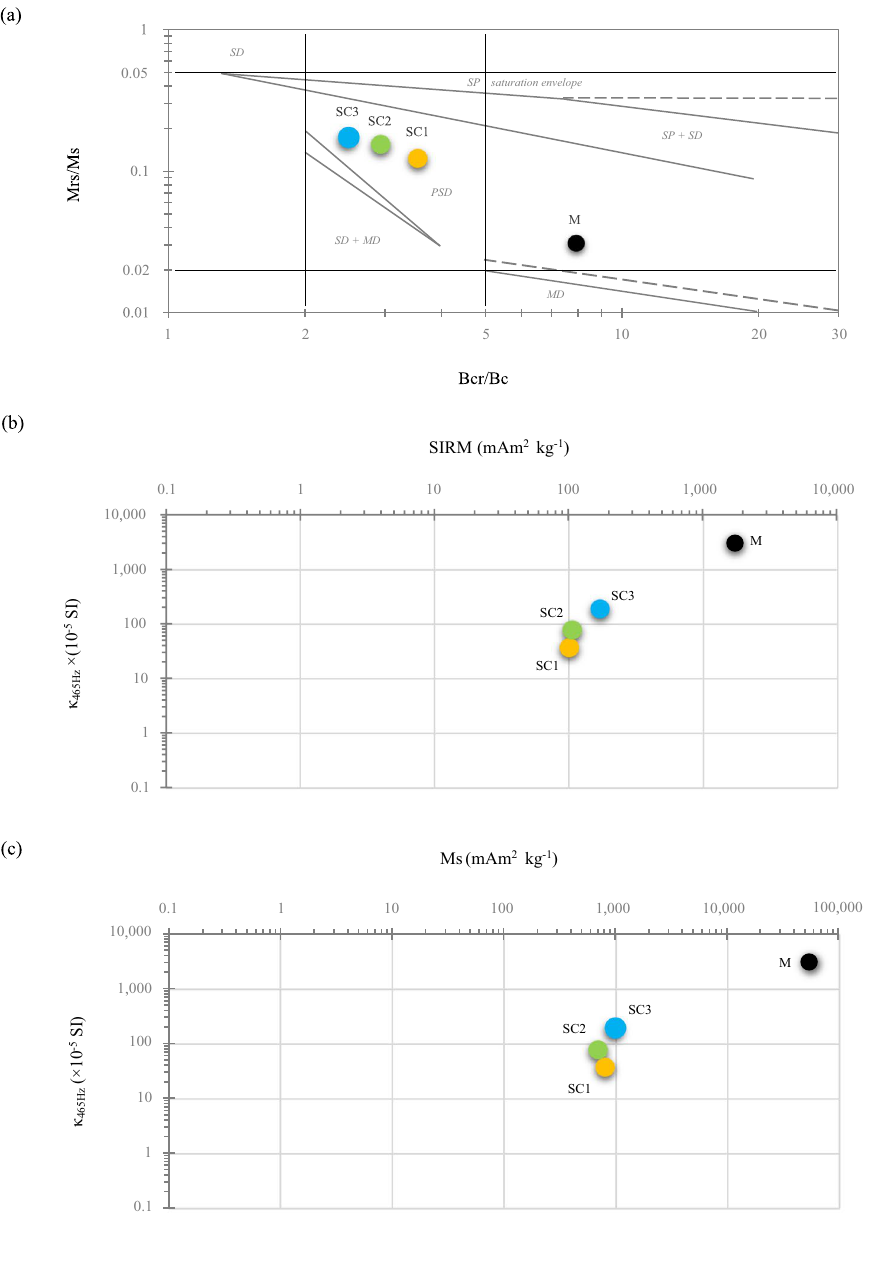
Figure 3. Illustration of hysteresis results for magnetite/maghemite (M) and soil concretion (SC1-3) samples. ( a ) The Day diagram 57 with modification of Dunlop 58 . Bi-logarithmic plots of: ( b ) SIRM vs. κ 465Hz ; ( c ) Ms